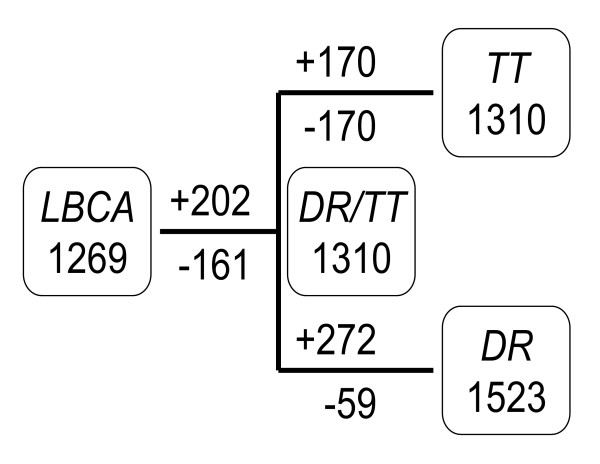
The reconstructed evolutionary scenario for the Thermus-Deinococcus clade. LBCA – Last Bacterial Common Ancestor; DR-TT – the common ancestor of Thermus-Deinococcus clade; TT – T. thermophilus; DR- D. radiodurans. Total number of COGs is shown in boxes for each node. '+' indicates inferred gene (COG) gain, and '-' indicates inferred loss.